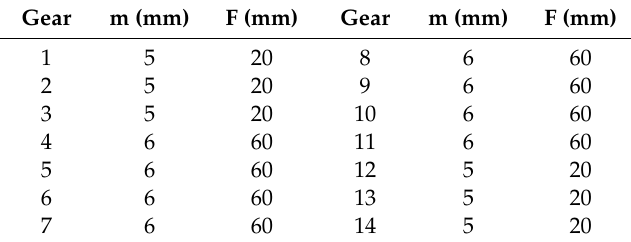
Table 2. Gear module and face